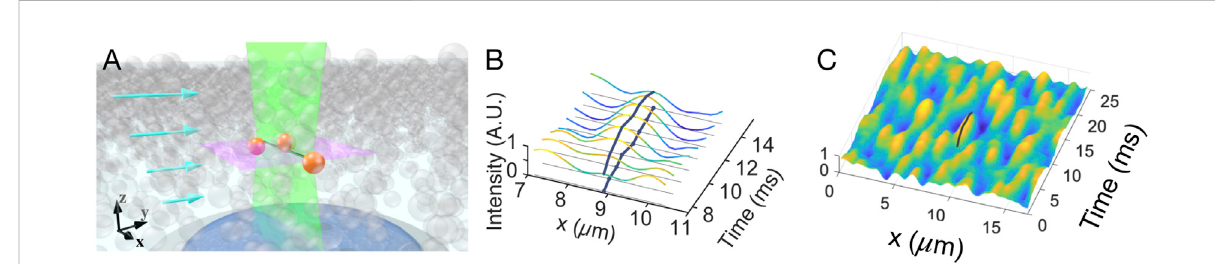
FIGURE 1 (A) Schematic of linescan imaging of a sheared dense suspension. The illumination laser rapidly scans back and forth, focused along the green line.Particlestransitingthelineareilluminated(orange).Theimagingregionfortheusual2Dlaserscanisindicatedbythedashedline,andthearrows represent the average velocity fi eld of the sheared suspension. The depth of focus (effective width of the image plane in z ) depends on the optical setup, and is ~ 1 μ m here) (B) Graphical representation of the linescan data, where the continuous colored lines represent a small portion of each individual scan,separated byashort interval.A fl uorescentparticletransiting thescanregion produces alocal intensity maximum (marked with a black line). (C) Rendering of linescan data showing the passage of many particles. The transit time can be determined by the length of the ridge (black line) (Note that in what follows the solvent is fl uorescent but the particles are not, so the transit of particles produces local intensity